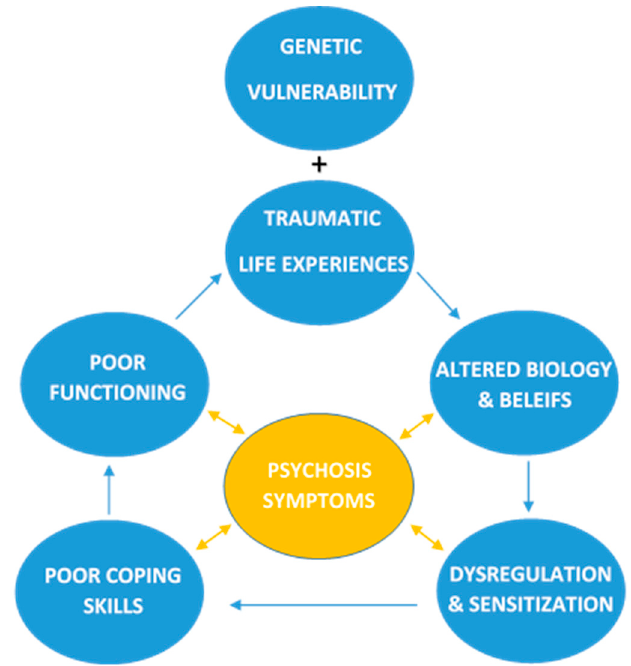
Figure 5. Diagram of how clinical correlates develop and contribute to functioning and psychosis symptoms .